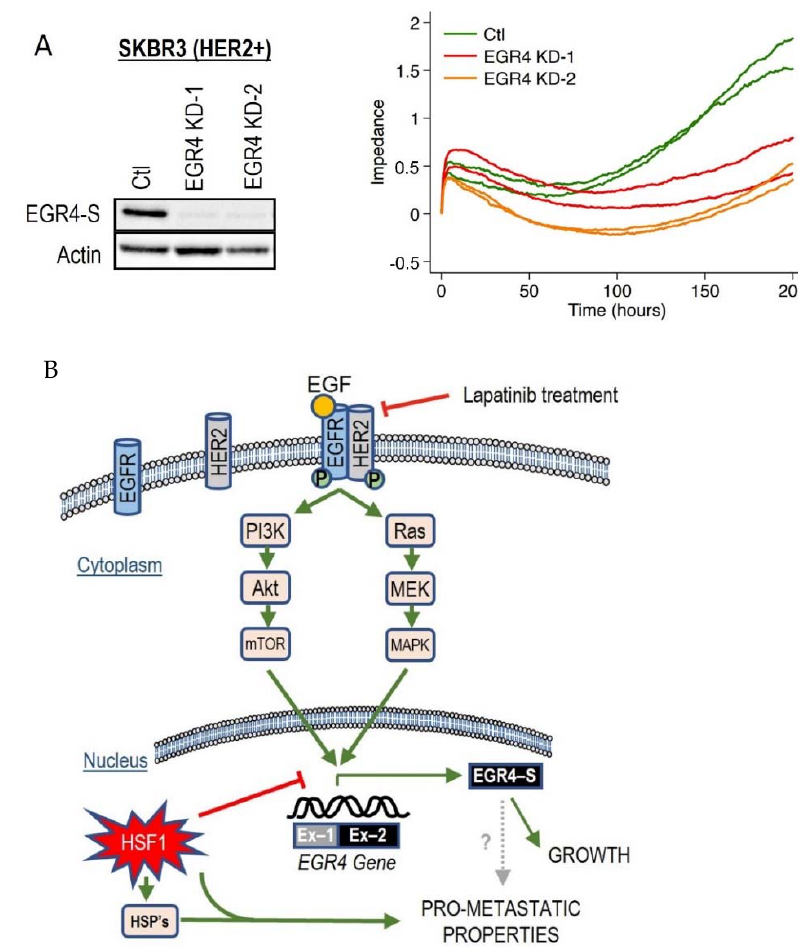
Figure 7. Effect of altered EGR4 expression on cancer cell growth. ( A ) xCELLigence Assay for HER2+ cell viability with/without EGR4-S knockdown (EGR4-KD) over time. ( B ) A schematic of the proposed EGFR(HER1)/HER2 signalling pathway and its relationship with the downstream transcription factor,